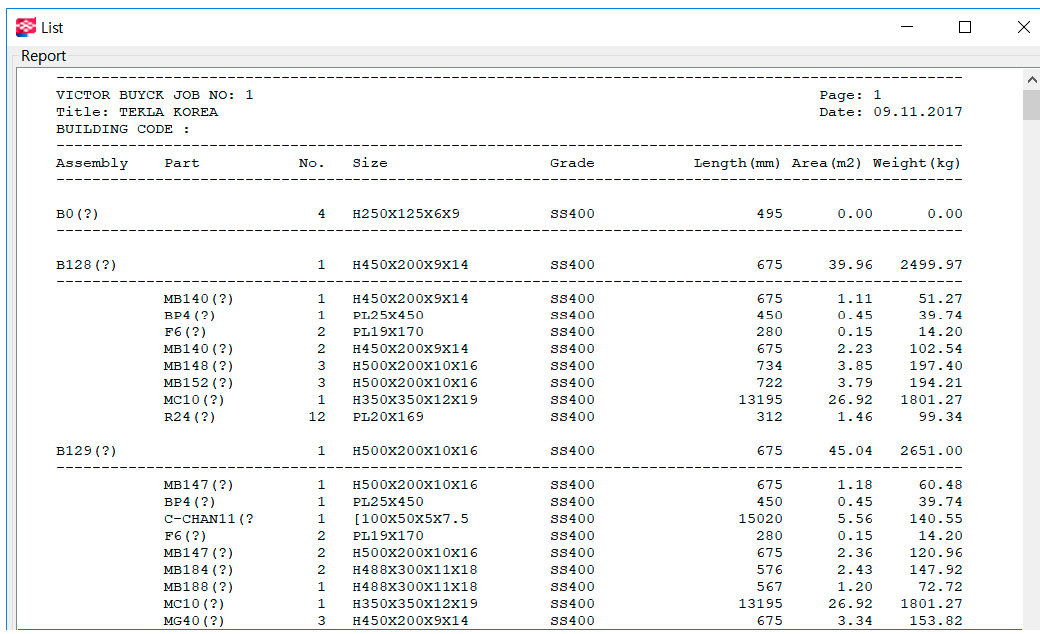
Figure 5. Information regarding the quantities of the steel frame members.